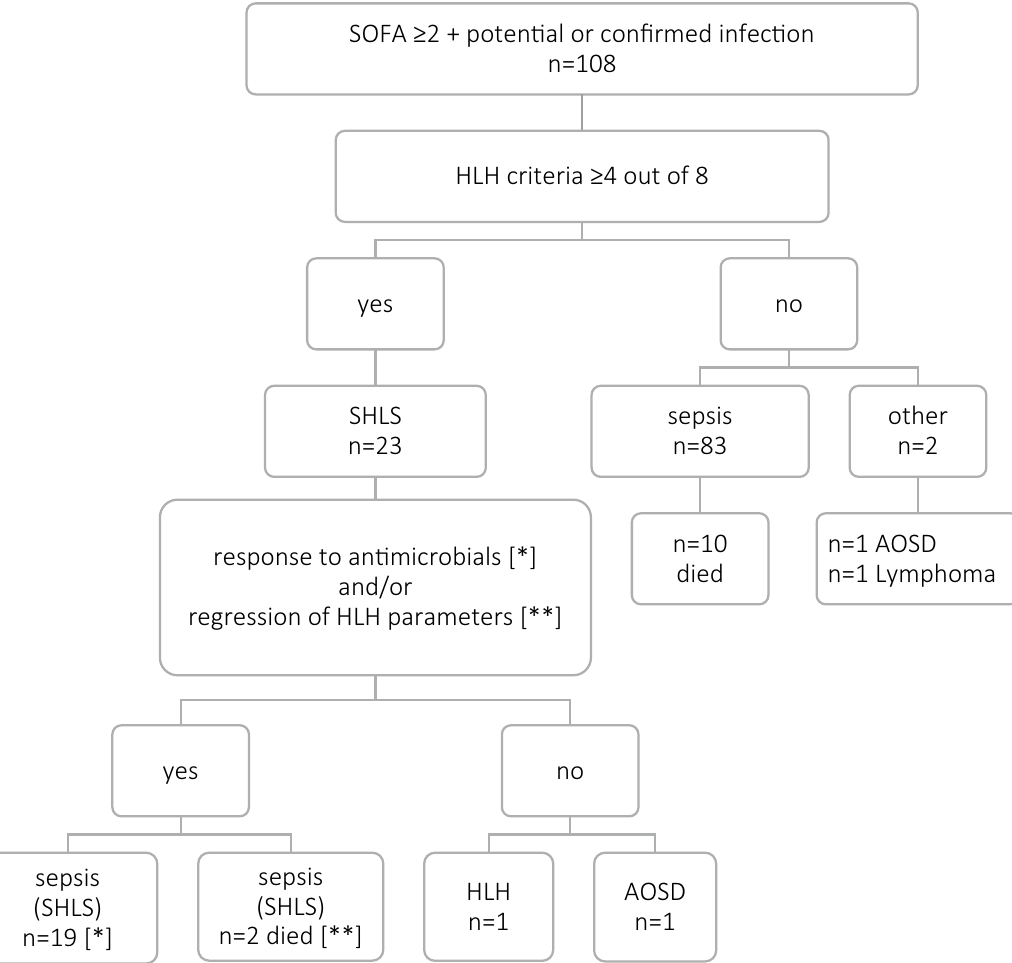
Figure 1. The results of routine assessment of HLH syndrome criteria in the patients with suspected sepsis (n = 108). SHLS – sepsis with HLH like syndrome, HLH—Hemophagocytic lymphohistiocytosis, AOSD – adult- onset Still’s disease.